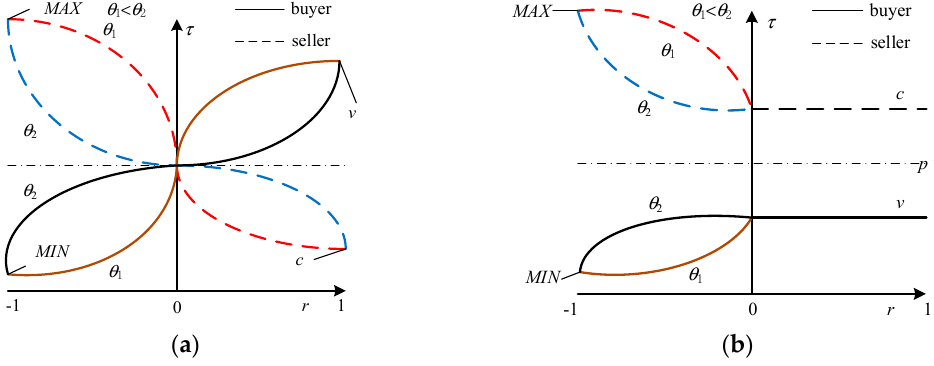
Figure 6. Relationship curve between target price and aggressiveness degree. ( a ) intra-marginal; ( b ) extra-marginal.